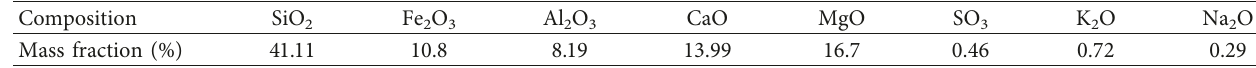
Table 1: Chemical composition of iron tailings powder.